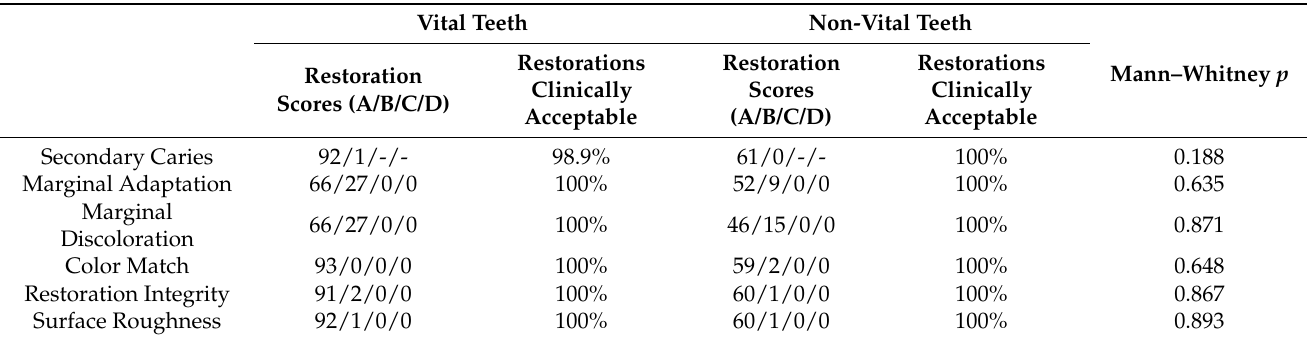
Table 3. Clinical evaluation of anterior porcelain veneers: comparison between vital and non-vital teeth, according to the United States Public Health Service criteria. Vital